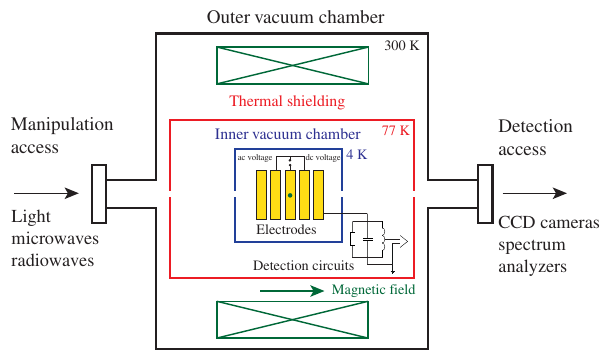
FIG. 1. Elements common to typical trap experiments. A set of electrodes supplied with ac and dc voltages is mounted in a vacuum chamber, optionally in a strong magnetic field. Cryo- genic traps have, in addition, thermal shielding and cryogenic vacuum chambers at low temperatures in their surroundings. The particles are manipulated with laser beams, microwaves, and radio-frequency (rf) generators. The signals are read out by detecting image currents or fluorescent